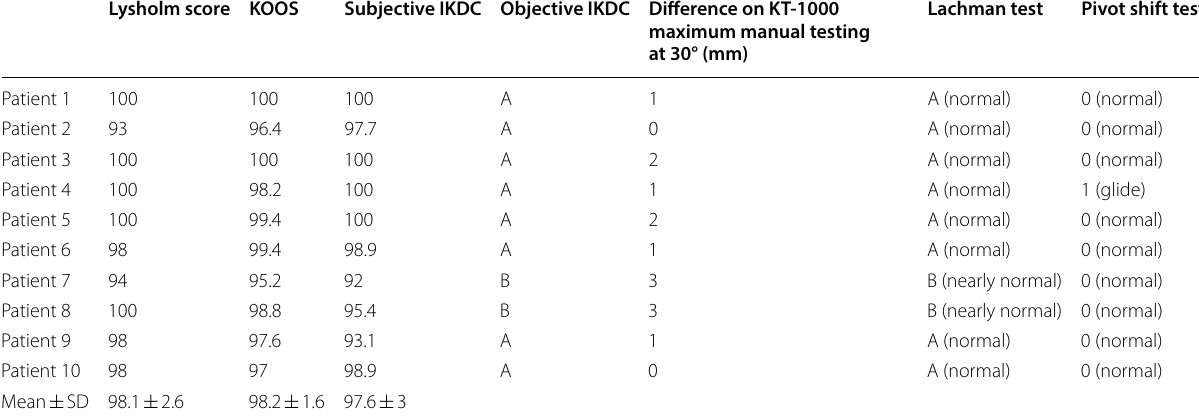
SD standard deviation, KOOS Knee injury and Osteoarthritis Knee Outcome Score, IKDC International Knee Documentation Committee